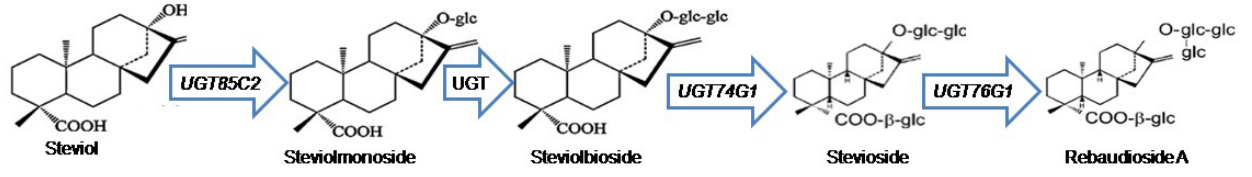
Figure 1. The simplified schematic MEP-pathway for SGs biosynthesis.